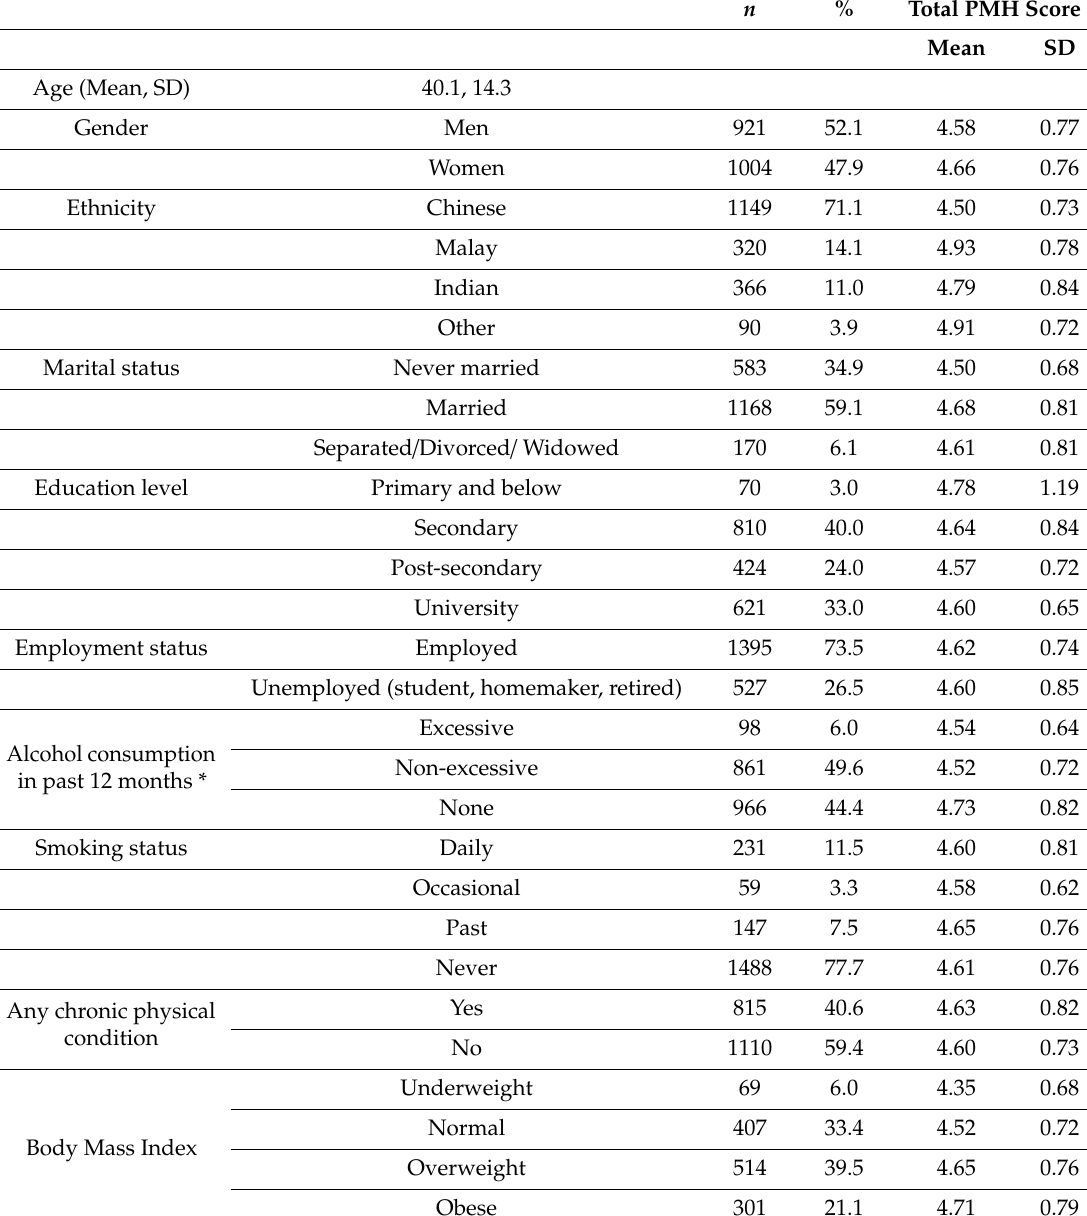
Table 1. Characteristics of the study sample and total positive mental health (PMH) scores for sub-groups ( n =